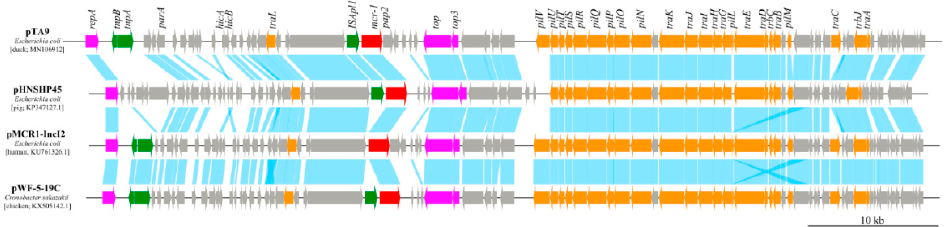
Figure 5. Colinear genome alignments of pTA9 from E. coli TA9 isolated in this study, pHNSHP45 from E. coli SHP45, pMCR1-IncI2 from E. coli SZ02, and pWF-5-19C from Cronobacter sakazakii WF-5- 19C.